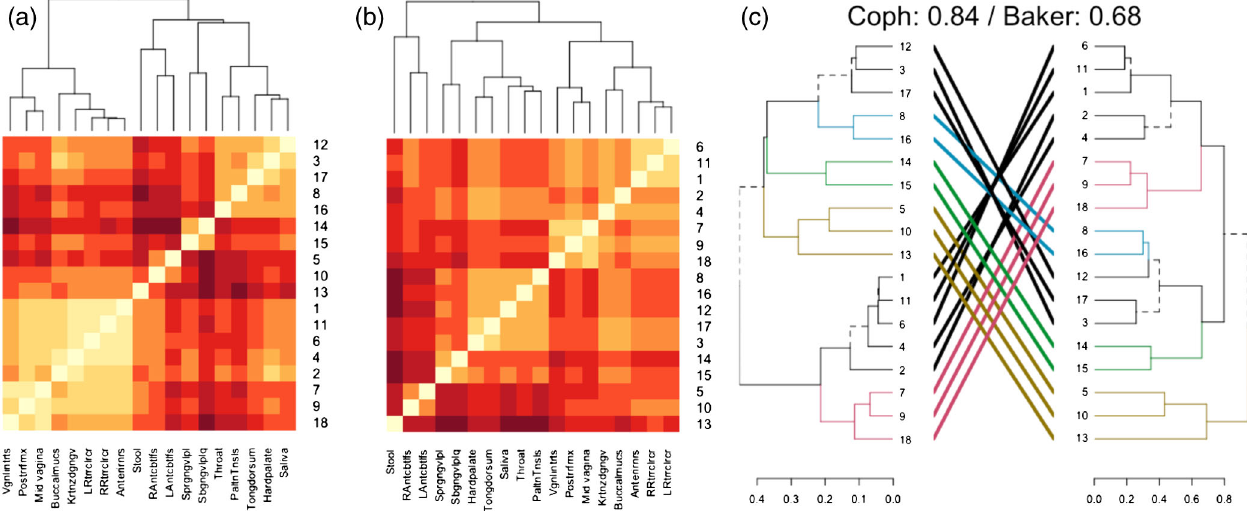
FIG. 6. Hierarchical clustering of human microbiome sites. The Jensen-Shannon distance matrices with (a) β ¼ 0 . 1 and (b) β ¼ 10 are shown, together with their (c) tantlegram, i.e., a visual analysis of their differences. Cophenetic distance and Baker ’ s gamma correlation coefficient, quantifying the correlation between the two dendrograms, are